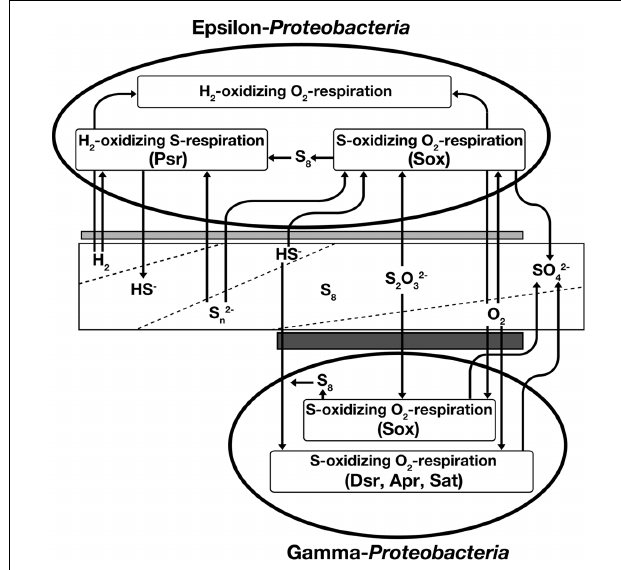
FIGURE 1 | Energy metabolic pathways and habitat area of epsilon- Proteobacteria and gamma- Proteobacteria in deep-sea hydrothermal fields. From left to right on the diagram, the redox conditions shift from reductive to oxidative states. Broken lines in the rectangle indicate inclines in concentration of hydrogen gas, hydrogen sulfide, oxidized sulfur compounds, and oxygen gas, respectively.Two gray bars indicate habitat area of epsilon- Proteobacteria and gamma- Proteobacteria , respectively. Psr, polysulfide reductase; Sox, Sox multienzyme system; Dsr, dissimilatory sulfite reductase; Apr, adenosine 5 (cid:2) -phosphosulfate reductase; Sat, sulfate